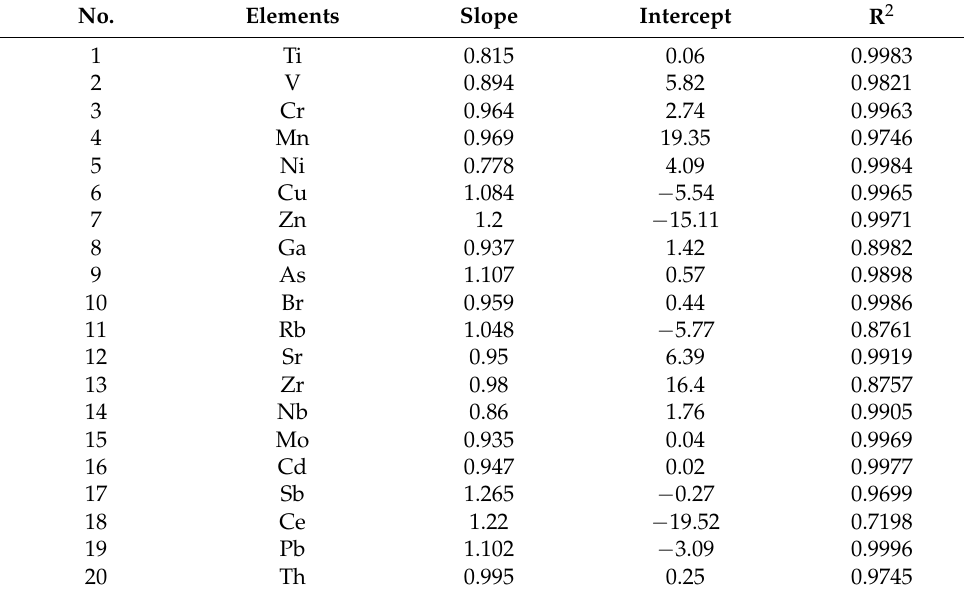
Table 4. Fitting equation of elements.